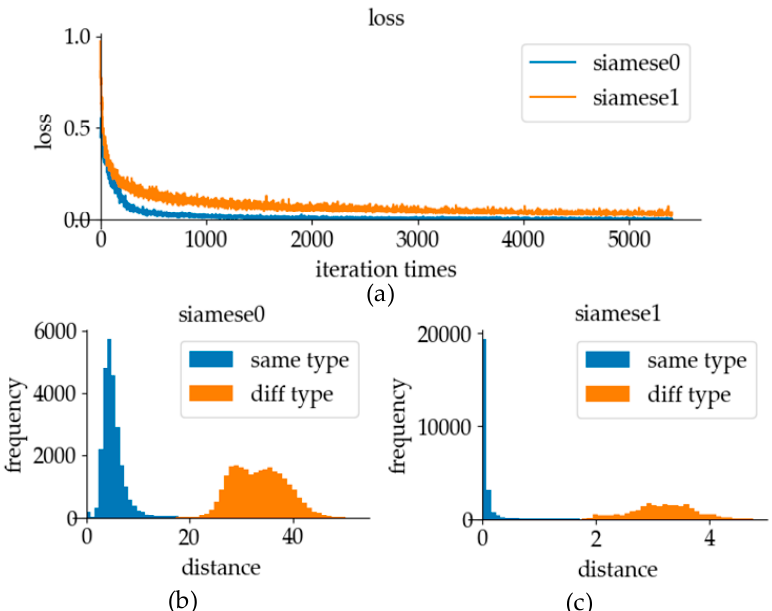
Figure 21. Experimental results compared with di ff erent loss functions. ( a ) The variation diagram of loss with iterations in two ways, wherein the siamese0 represents the contrastive loss used as the loss function in the training process, while the siamese1 represents the sigmoid modification function used. ( b , c ) Histograms of test results in two ways, where each long column represents the number of samples within the range of Euclidean distance, in which the “same type” represents the same type of data pair and the “di ff type” represents the di ff erent type of data pair. ( b ) shows the test results using the sigmoid modification function. ( c ) shows the test result diagram using the contrastive loss function.